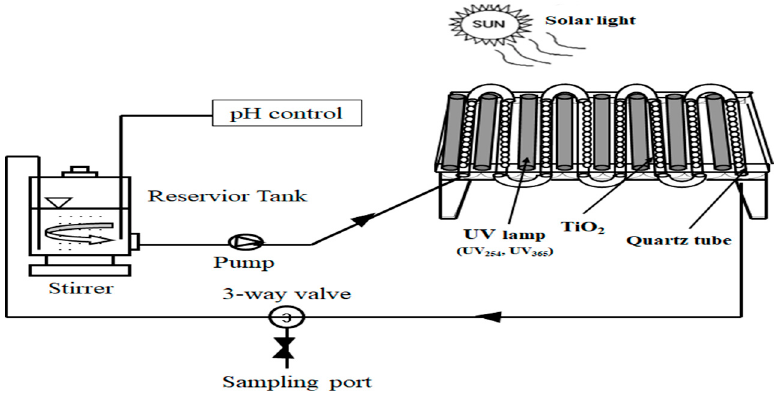
Figure 1. Schematic diagram of the photo-assisted Fenton reactor.